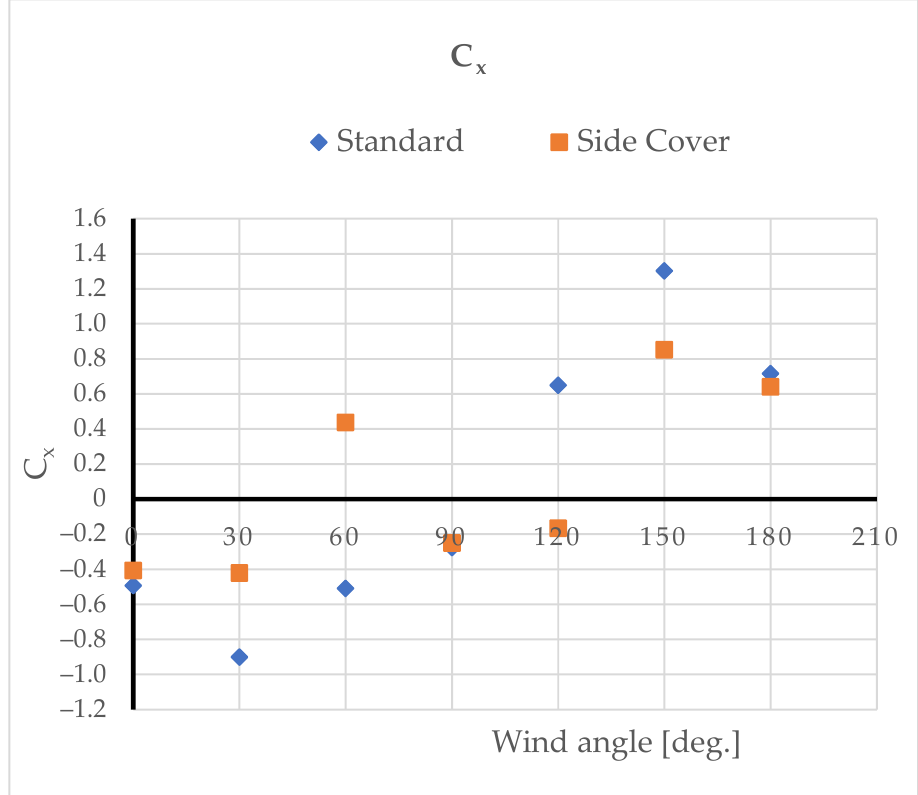
–1.2–1.0–0.8–0.6–0.4 Figure 34. Effect of side covers on the resistance coefficient at different wind angles. Figure 35. Effect of side covers on the side force coefficient at different wind angles.